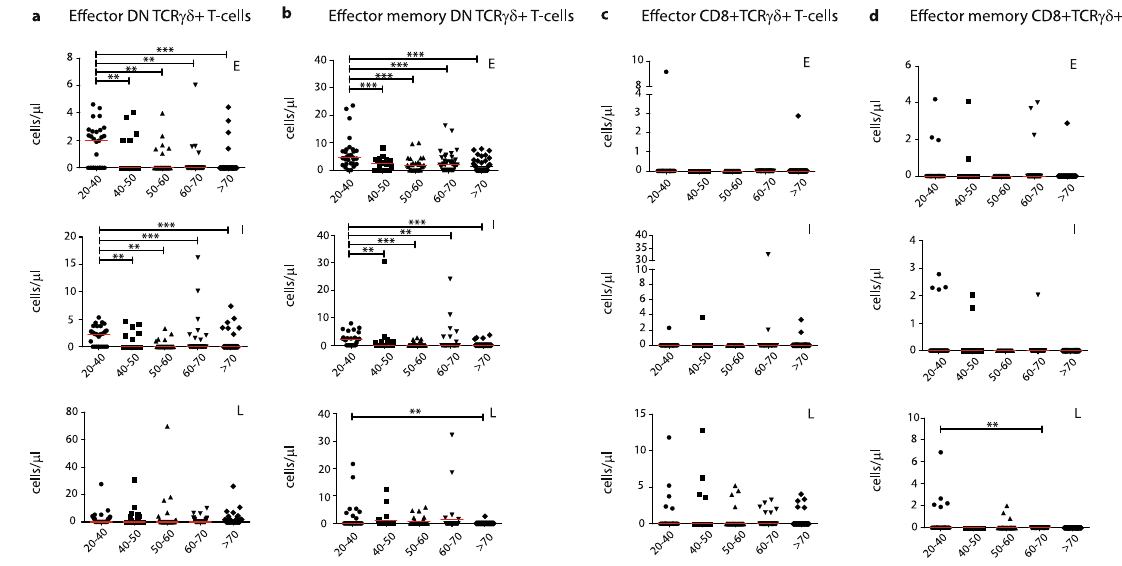
Figure 3. DN and CD8 + TCR γδ+ effector and effector memory differentiation stages during ageing. ( a ) Absolute numbers of early (CD27 + CD28 + ), intermediate (CD27 + CD28 − ) and late (CD27 − CD28 − ) differentiated DN and ( c ) CD8 + TCR γδ+ effector (CD45RO − CD197 − , Temra) T-cells. ( b ) Absolute numbers of early, intermediate and late differentiated DN and ( d ) CD8 + TCR γδ+ effector memory (CD45RO + CD197 − , Temro) T-cells. Early (E), intermediate (I) and late (L) definitions are indicated in the upper right corners of the graphs. Scatter plots are indicated with the median. Significance was tested by a Kruskal-Wallis test, followed by a post-Dunn’s test for correction for multiple testing. Significance for the Dunn’s test is indicated in the plots: ** p < 0.01; *** p <